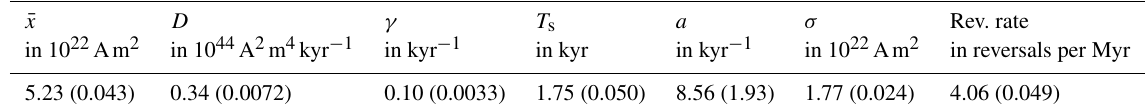
Figure 6. One- and two-dimensional histograms of the posterior distribution. Table 4. Posterior mean and standard deviation (in brackets) of the model parameters and corresponding estimates of the reversal rate and VADM standard